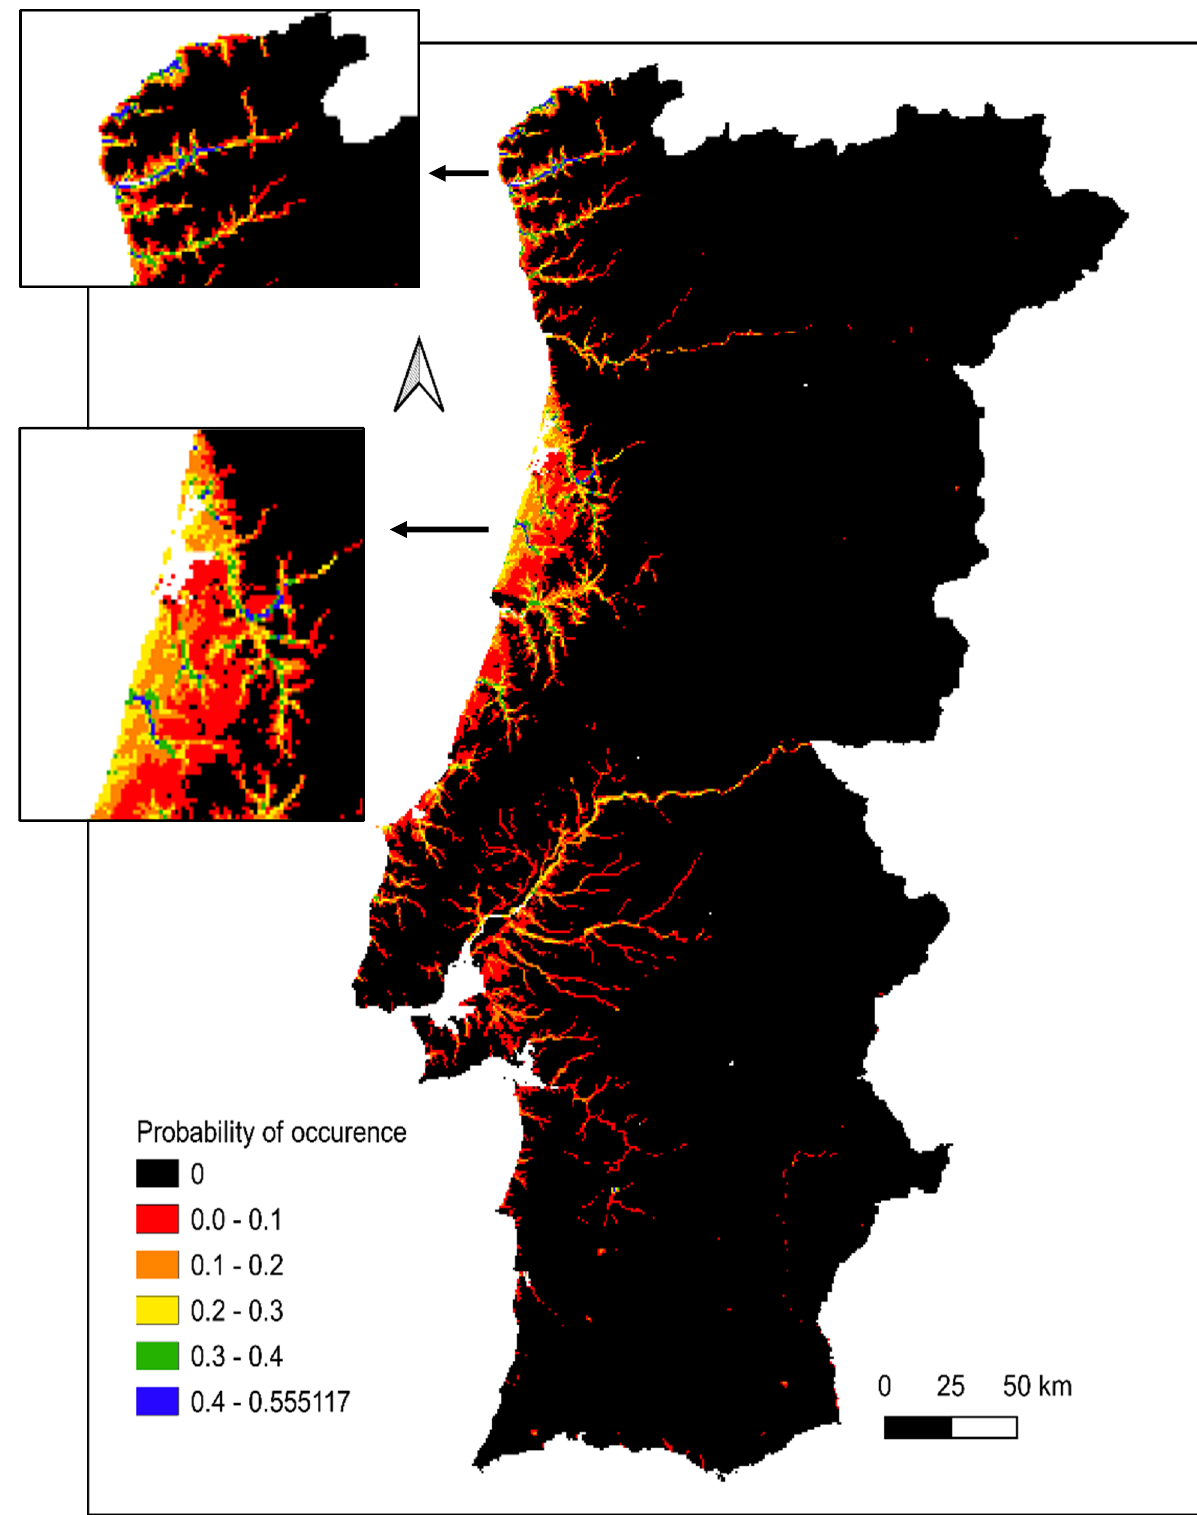
Figure 3. Distribution of G. aculeatus probability of occurrence in mainland Portugal, with highlights on the areas with highest probability of occurrence of this species.